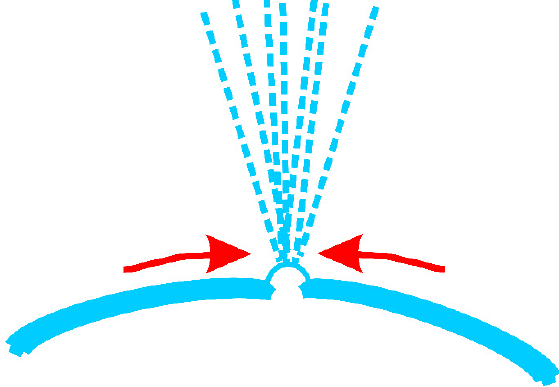
Figure 6. ( a ) Jet formation and ( b ) its mechanism in critical bubble electrospinning (7 wt % PVA solution).